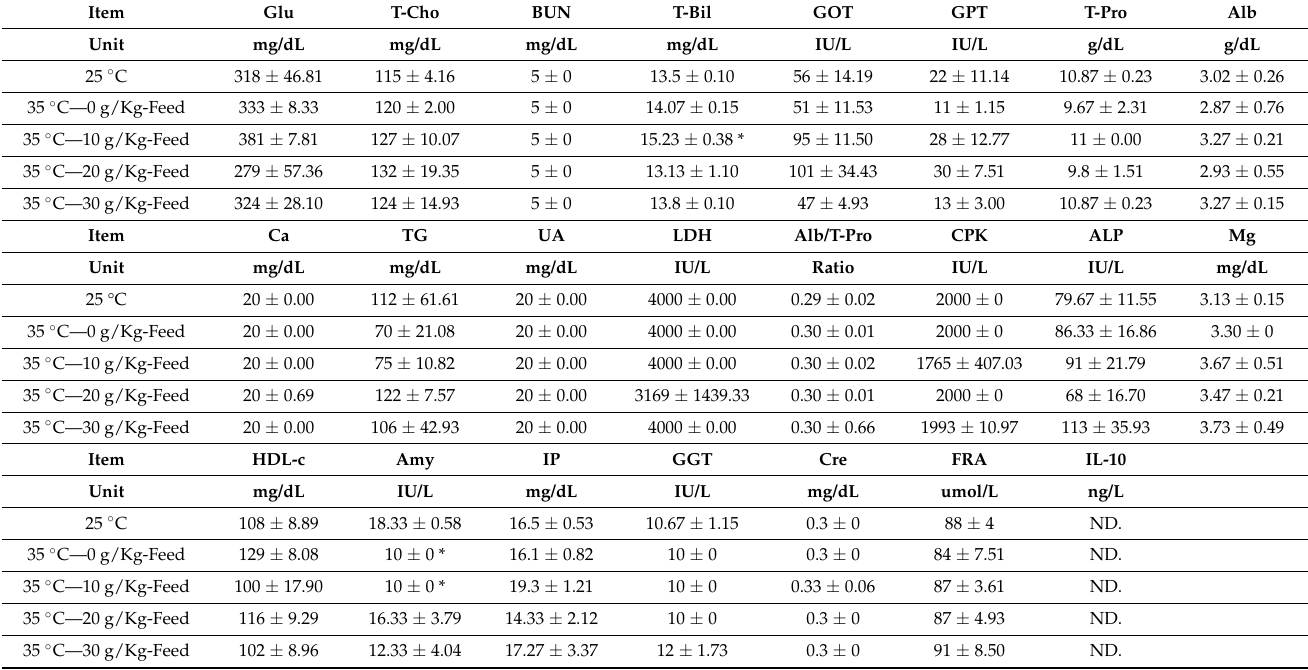
Table 1. The Nile Tilapia blood biochemical analysis. Serum indices of Nile Tilapia fed with acetyl- xylogalactan for 4 weeks under heat stress, * indicates p < 0.05, wherein each treatment group was compared to the control group.